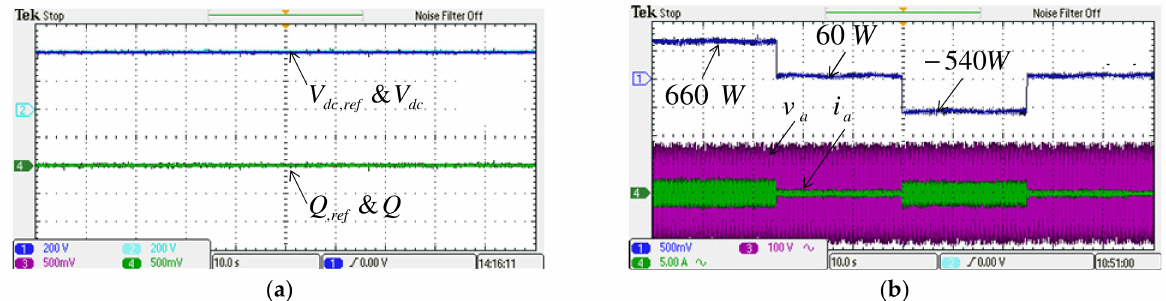
Figure 19. Implemented grid inverter waveforms in case 1: ( a ) DC link voltage and reference/reactive power and reference; ( b ) active power/a phase voltage and current.